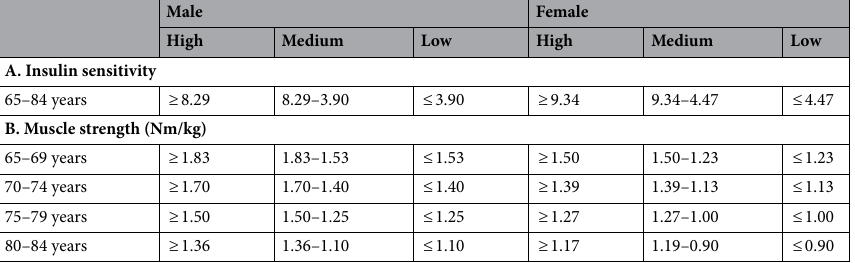
Table 3. Cut-off values for insulin sensitivity and muscle strength. A. Categorized for three groups based on the standard deviation (SD) of sex (male/female)-specific value of PREDIM. B. Categorized for three